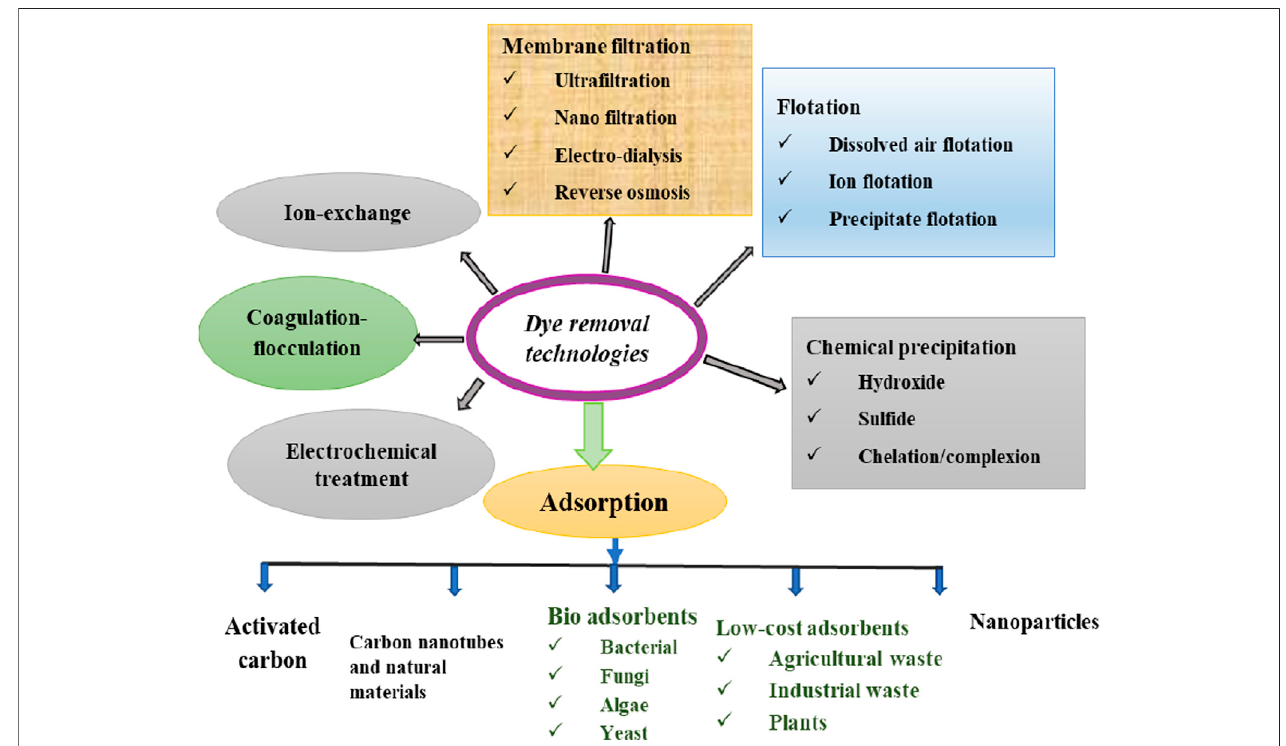
FIGURE 2 | Schematic representations of available dye removal technologies: adopted with modi fi cation from Roy and Saha (2021).